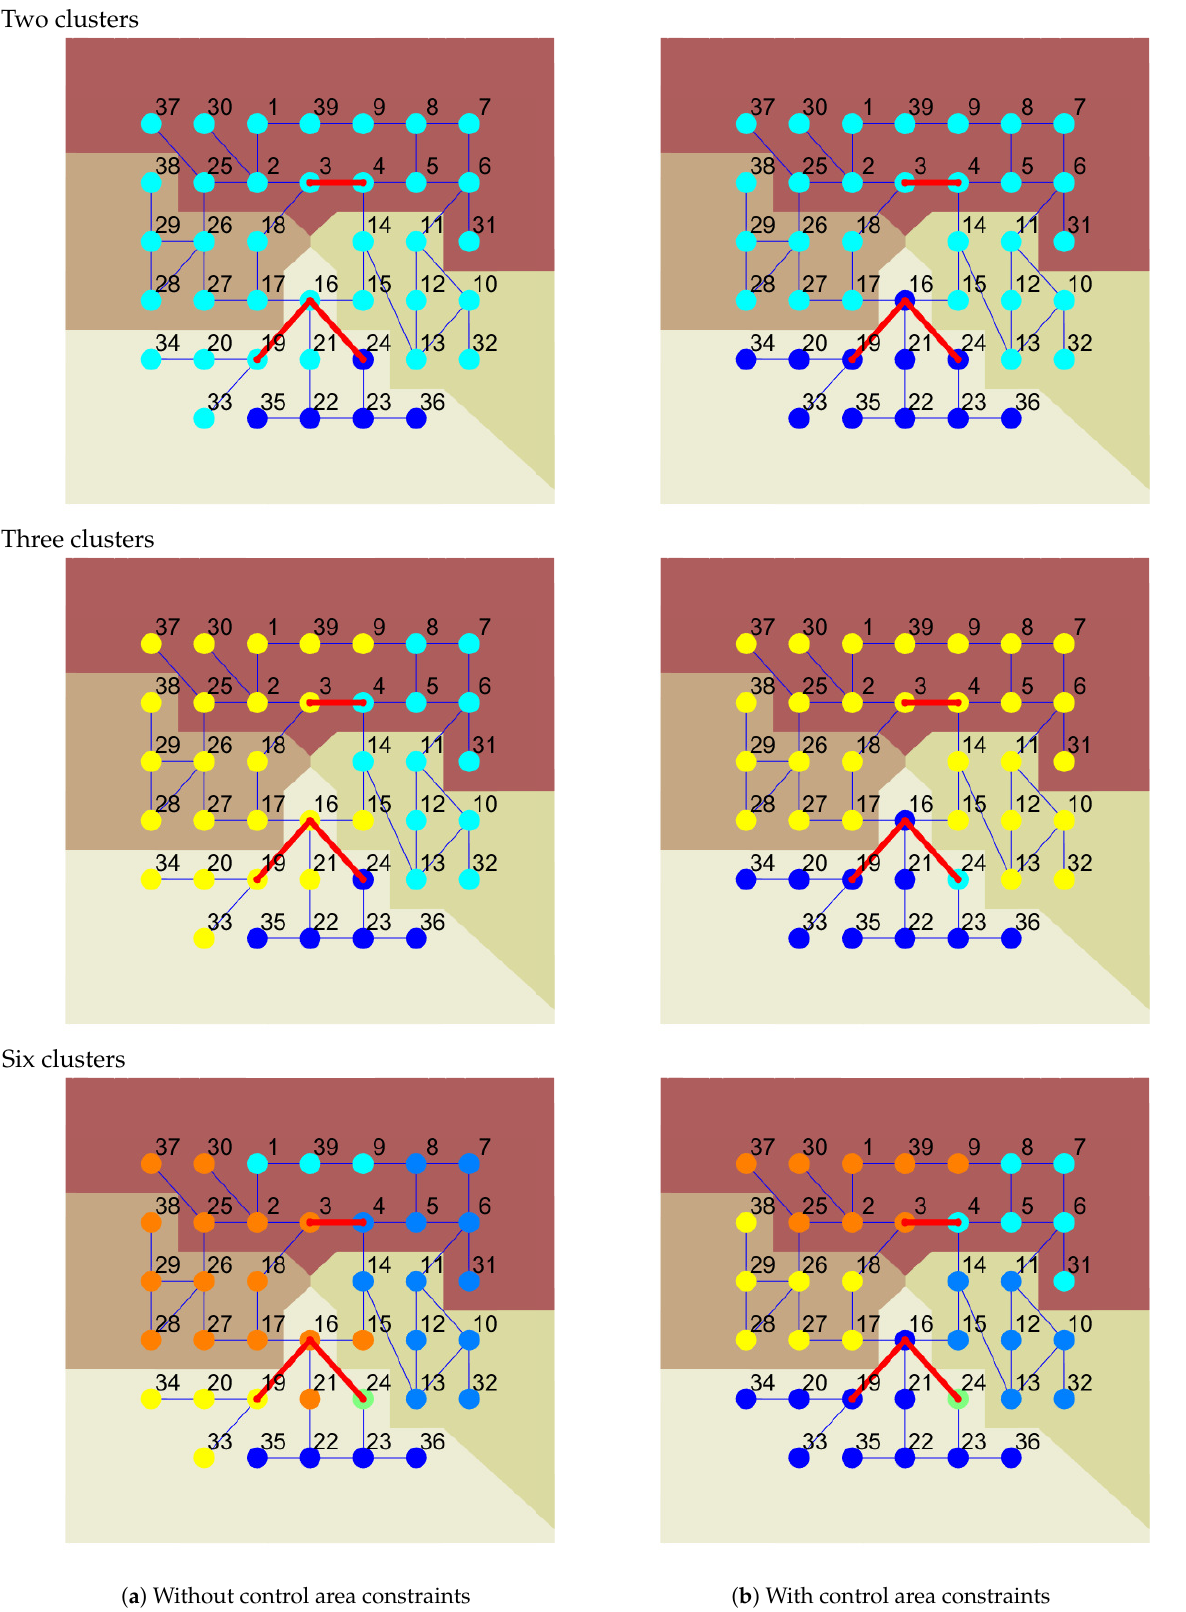
Figure 7. Comparison of bidding zones delimitation without ( a ) and with ( b ) control area constraints for 2 ( top figures ), 3 ( middle fig- ures ) and 6 ( bottom figure ) clusters. In the plot background colour represents control areas and node colour indicates obtained bidding zones